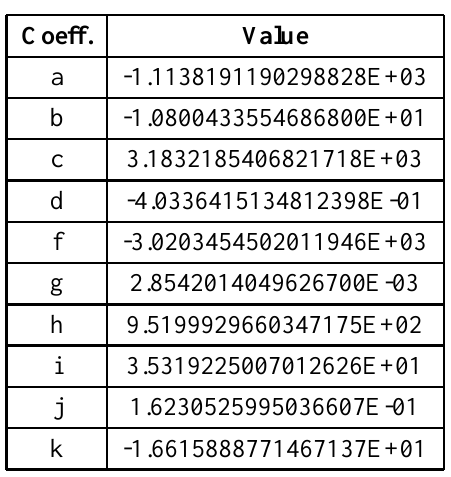
Table 4. Proposed equation coefficients.